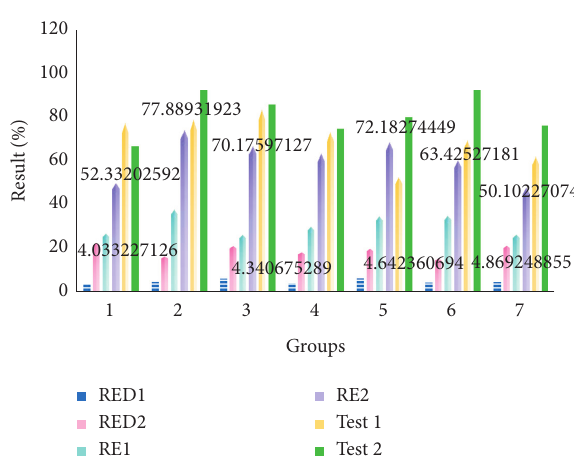
Figure 3: Simultaneous release behavior of CLB and DOX from the mesoporous multifunctional nanomicelle combined drug delivery system under different